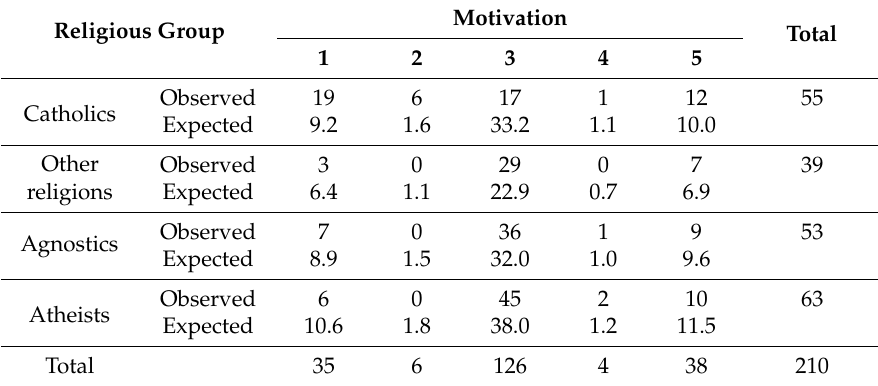
Table 2. Relations between religious affiliation and motivations for nature